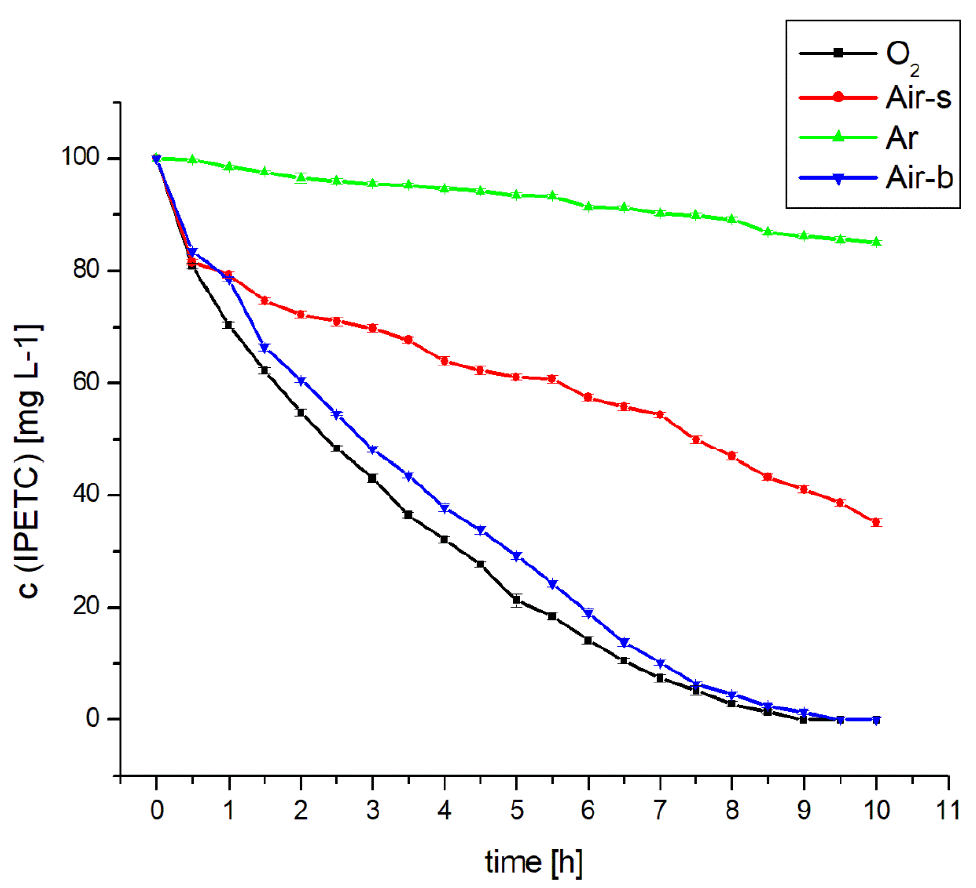
Figure 1. Decomposition of IPETC under UV-A light in the presence of FeCl 3 in solutions with various concentrations of oxygen. Curve Ar: solution purged with argon. Air-s: saturated with air, no bubbling. Air-b: air bubbled continuously. O 2 : oxygen bubbled continuously.